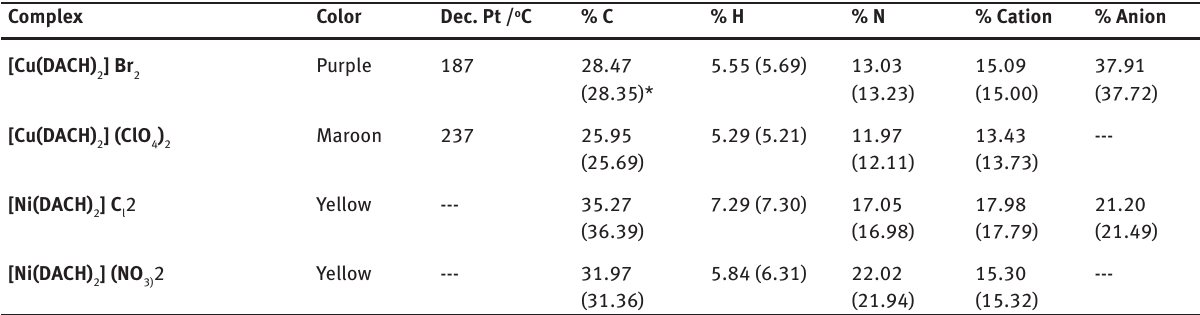
Table 1: Analytical data of metal complexes of DACH. Complex